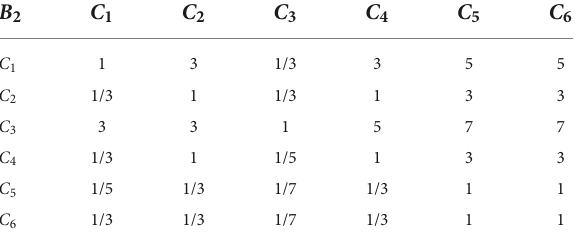
TABLE 5 Judgment matrix of emissions to human hazards.